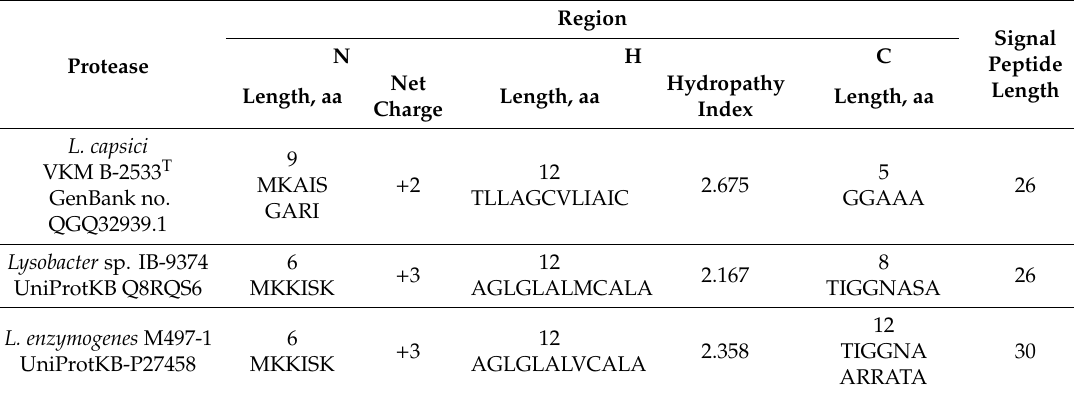
Table 1. Organizations of Blp signal peptides compared *.